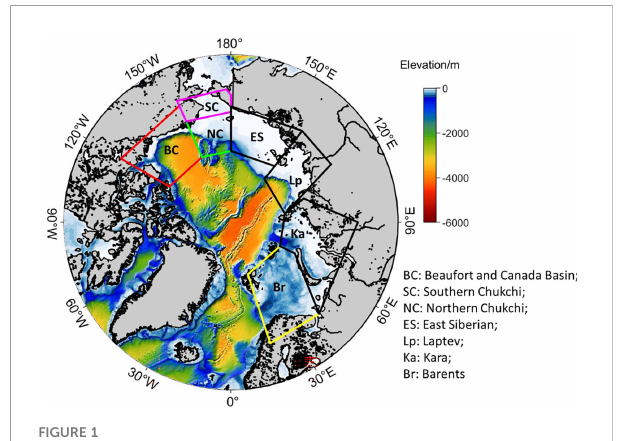
Kara (Ka); Barents